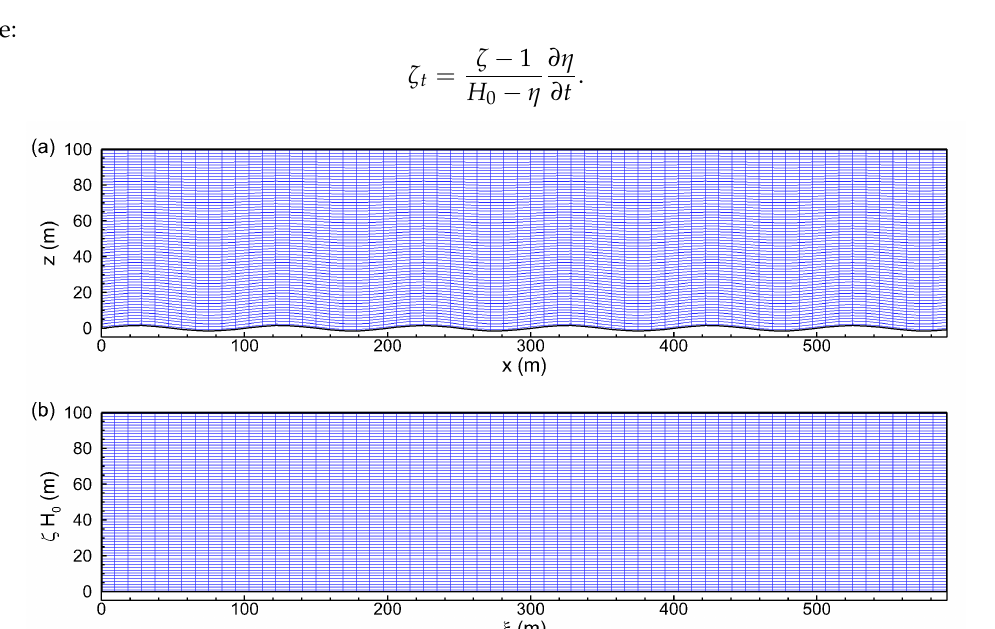
Figure 1. Illustration of boundary-fitted grid and coordinate transformation: ( a ) ( x , z ) -plane in the physical space; ( b ) ( ξ , ζ ) -plane in the computational space. For illustration purposes, the grid lines shown in ( a , b ) are plotted for every two actual grids used in the